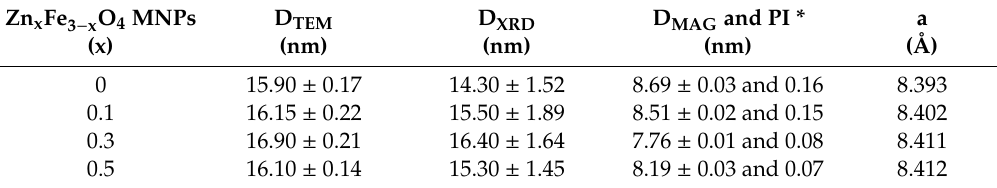
Table 1. Structural properties of Zn x Fe 3 − x O 4 MNPs.